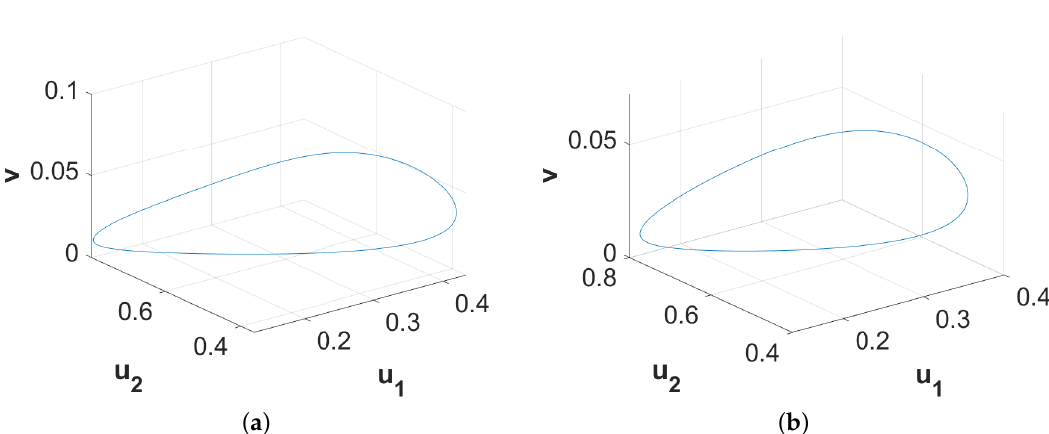
Figure 17. Phase diagrams of spatial average densities of the associated three species corresponding to ( a ) Figure 16a, ( b ) Figure 16b.